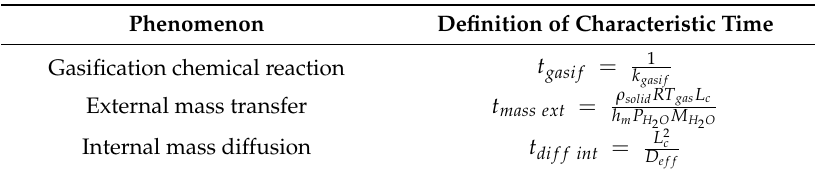
Table 4. Characteristic time definition for the gasification of